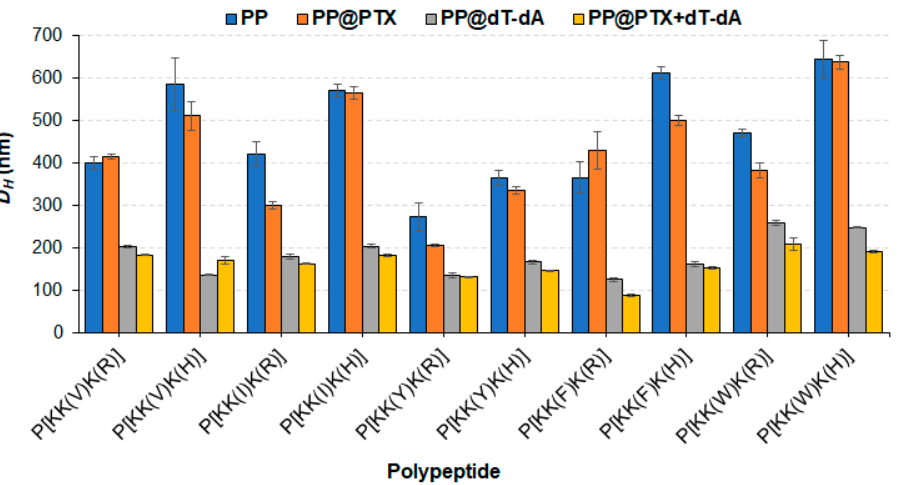
Figure 5. Comparison of hydrodynamic dimeters of empty polypeptide particles (PP), single-laded particles containing PTX (PP@PTX) or oligo-dT-dA (PP@oligo-dT-dA), as well as dual-component